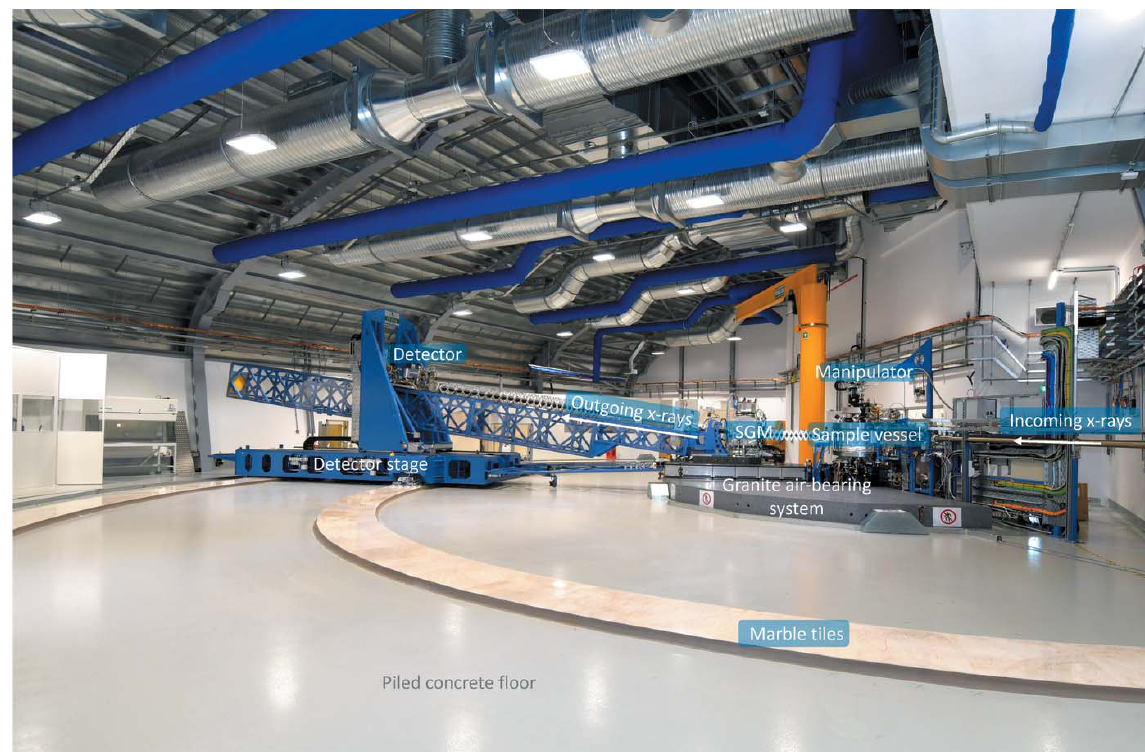
Figure 18 Overview of the I21 RIXS